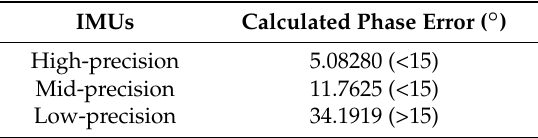
Figure 4. Comparison diagram of phase detecting error aided by three kinds of IMUs. Table 4. The phase errors calculated by the left-hand side of Equation (27) for the three kinds of IMUs.